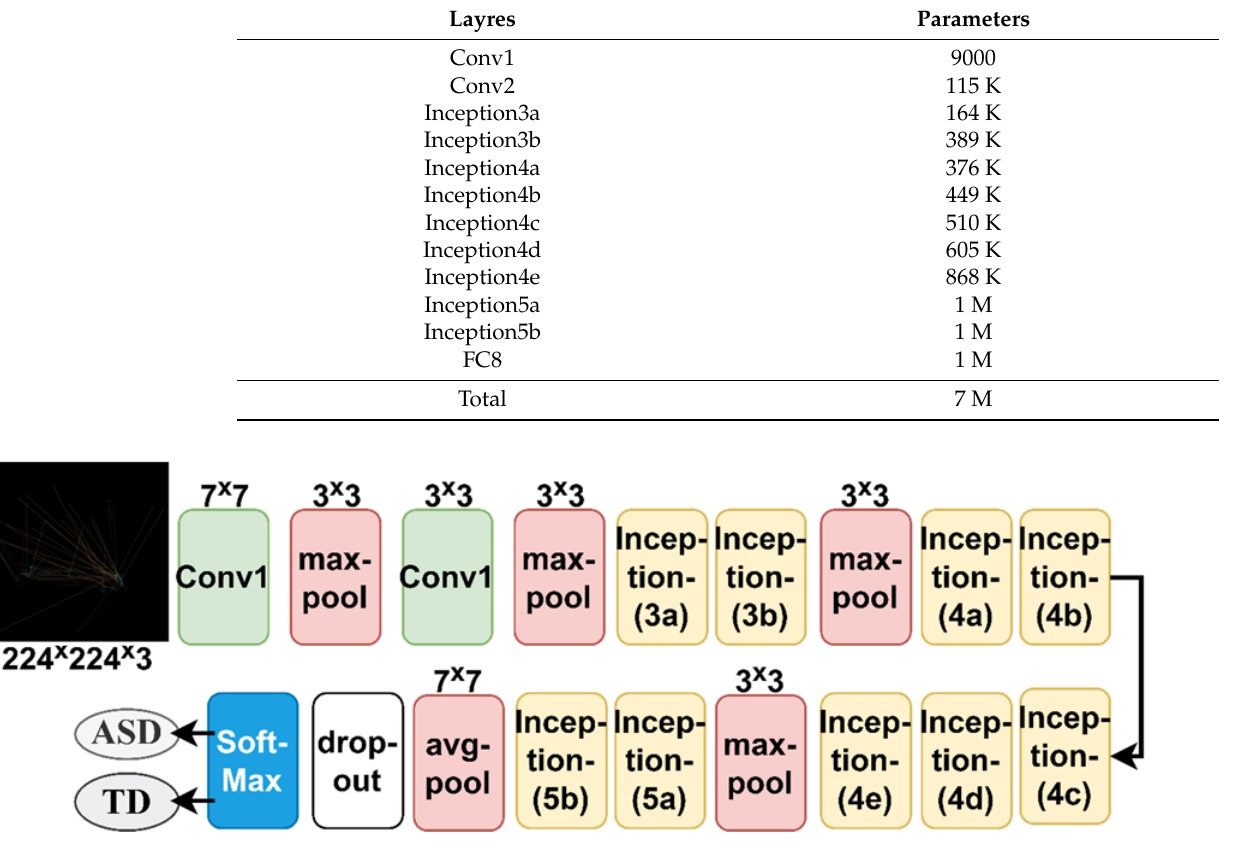
Figure 7. Structure of GoogLeNet model.